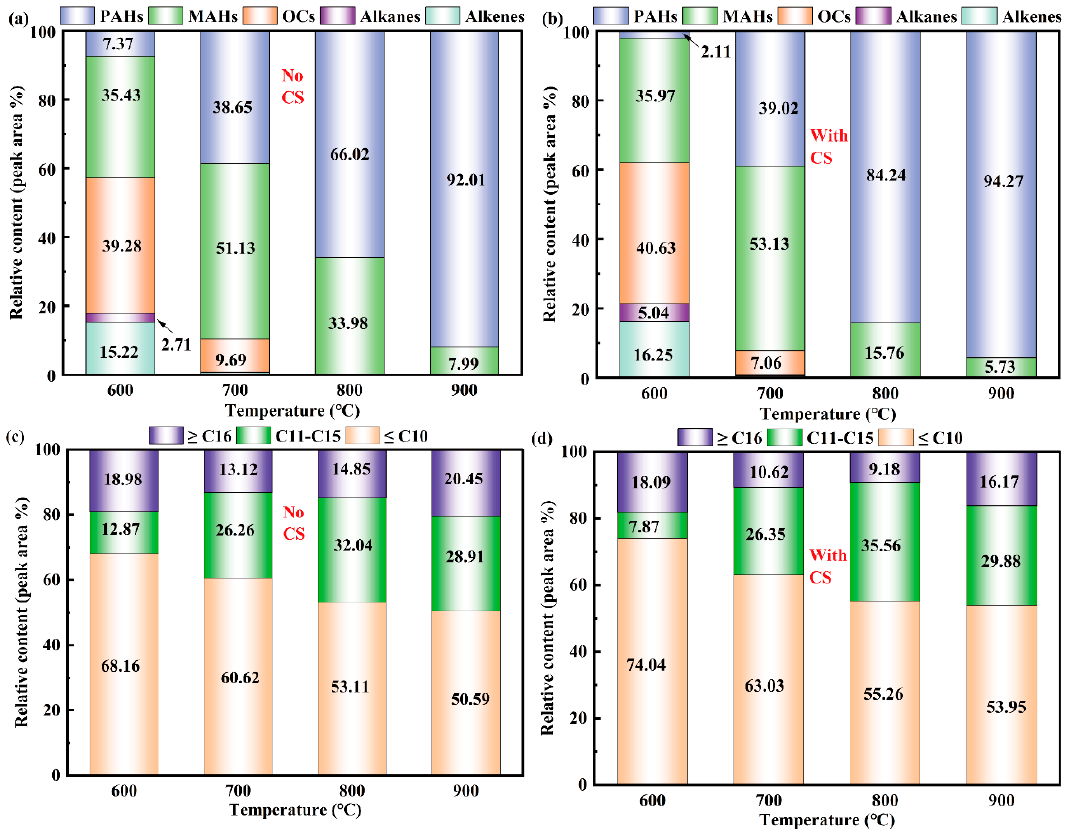
Figure 11. Liquid products of WCO-Biodiesel under the influence of CS at 600, 700, 800 and 900 °C: ( a , b ) classification of products based on their type; ( c , d ) classification of products based on the number of carbon atoms.